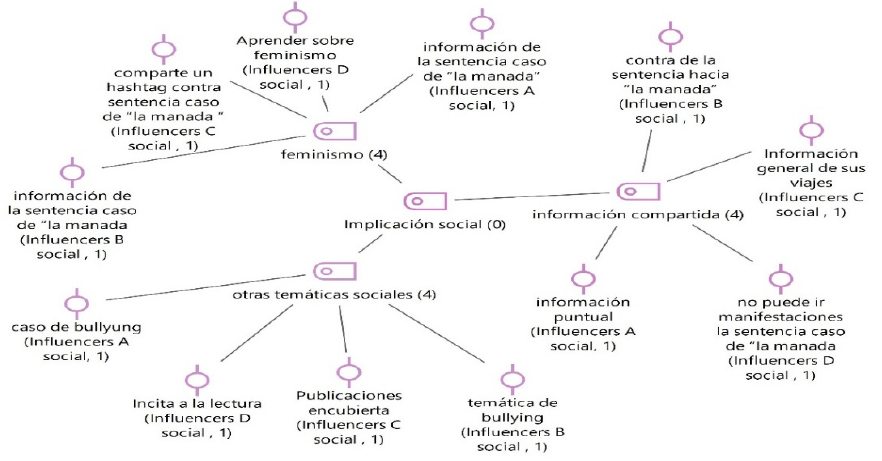
Figure 4. Categories and codes: Social engagement.